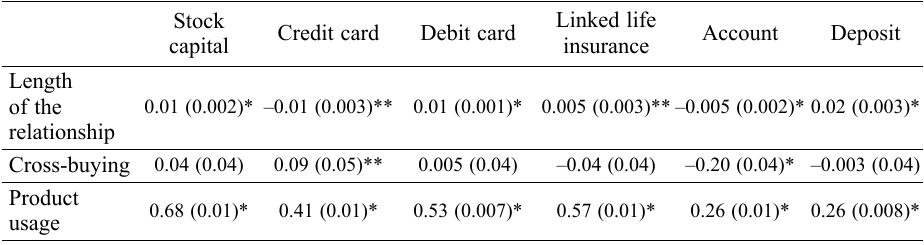
Table 4. Parameter estimates for multivariate Probit model (Coefficient (standard